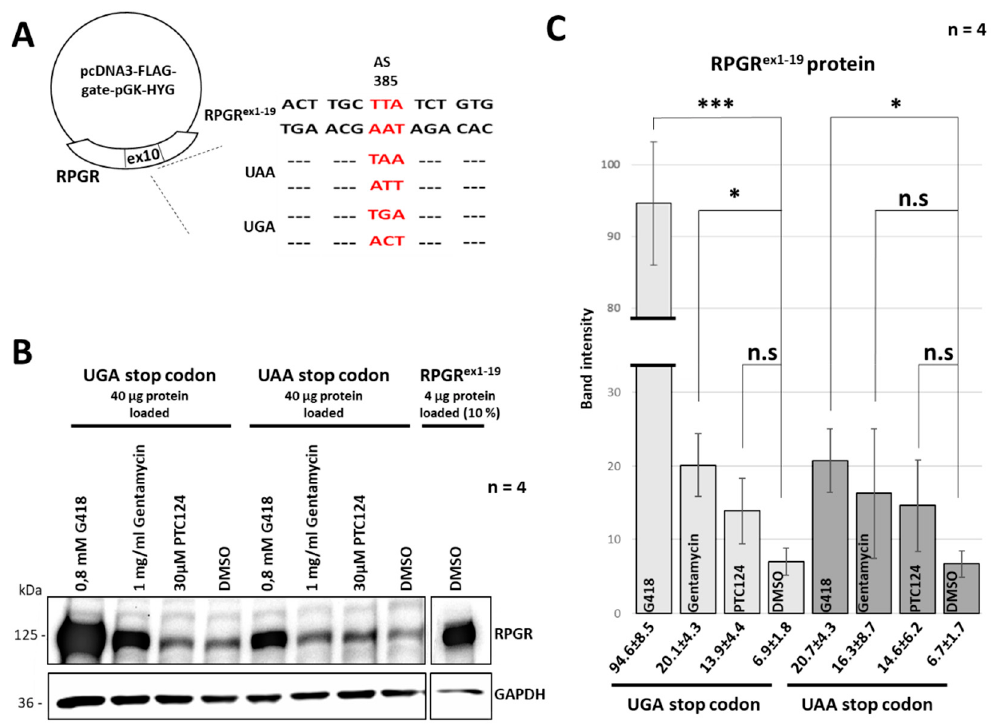
Figure 3. PTC124 treatment partially restores RPGR expression. ( A ) RPGR expression constructs encoding the full-length RPGR protein encoded by exon 1 through 19. Expression constructs were mutated with either an UAA stop codon (RPGR- UAA stop codon) or a UGA stop codon (RPGR- UGA stop codon) at amino acid position 384. The RPGR expression construct encoding the reference RPGR ex1–19 protein was used as a control. Sequence alterations in the expression construct are highlighted in red. ( B ) RPGR expression constructs were transfected into HEK293T cells and treated with either a single dose of PTC124, G418, Gentamycin or DMSO for 48 h. Full-length RPGR was detected applying a polyclonal RPGR antibody directed against amino acids 379 to 509 of RPGR. The treatments with G418 and gentamycin partially restored the full-length RPGR protein expression. Read-through efficacies of the reagents PTC124, G418 and gentamycin were compared to samples incubated with DMSO. The experiments were replicated four times (n = 4). GAPDH (36 kDa) was used as a loading control. Protein sizes are indicated on the left side in kDa. ( C ) Quantification of the band intensities suggested that all read-through-inducing reagents led to an upregulation of the expression of full-length RPGR protein. Levels were normalized to GAPDH signal intensities and compared to the negative control (DMSO). The quantification was based on four independent replicates (n = 4). Error bars represent standard deviation. Asterisks: significant differences; n.s: non-significant, *: p ≤ 0.05, ***: p ≤ 0.001.